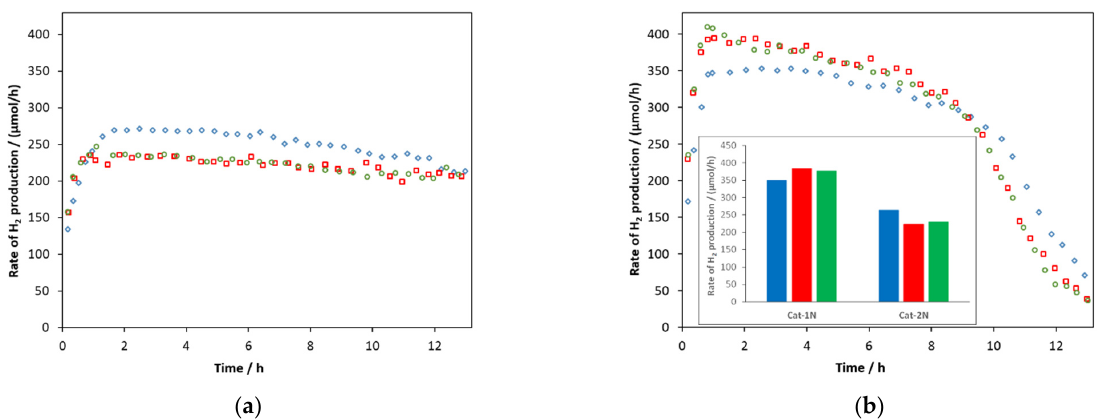
Figure 11. ( a ) The rate of H 2 production of Cat-2N for 3 cycles as a function of time from a 0.13M Na 2 S/0.18 M Na 2 SO 3 solution, ( b ) the rate of H 2 production of Cat-1N for 3 cycles as a function of time from a 0.13M Na 2 S/0.18M Na 2 SO 3 solution (inset: the overall rate of H 2 production of Cat-1N and Cat-2N for 3 cycles between 200 and 400 min). The blue, red, and green colors designate the 1st, 2nd, and 3rd illumination.